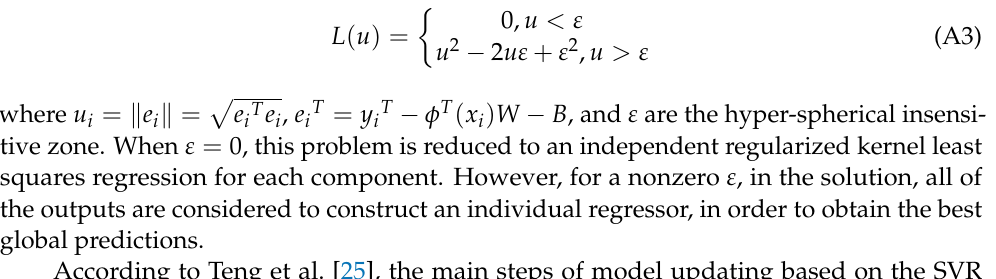
Figure A1. Sampling results based on orthogonal experimental design.